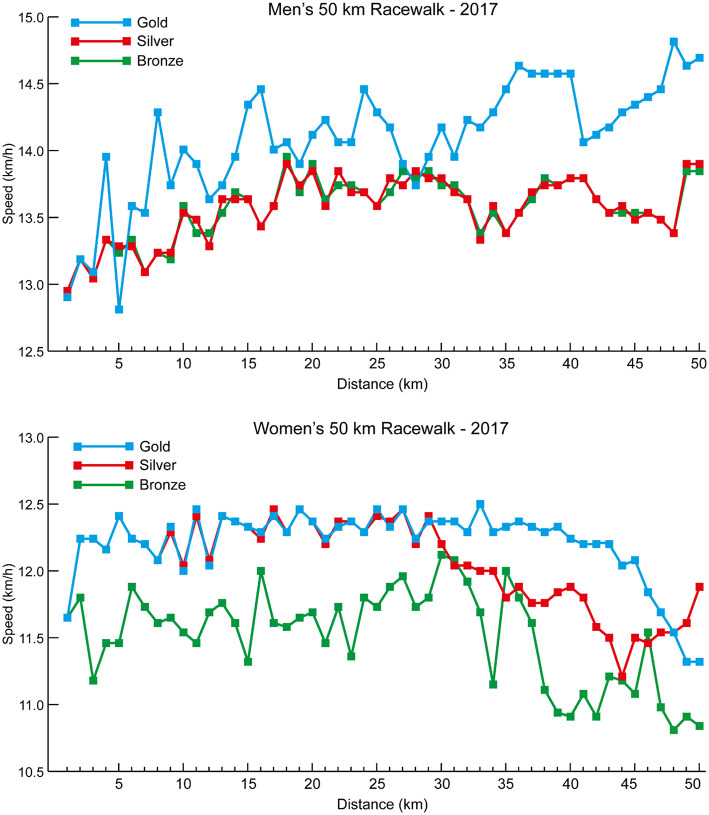
The individual 1-km segment speeds for the medalists in the men's and women's 50 km racewalk events at the 2017 IAAF World Championships.